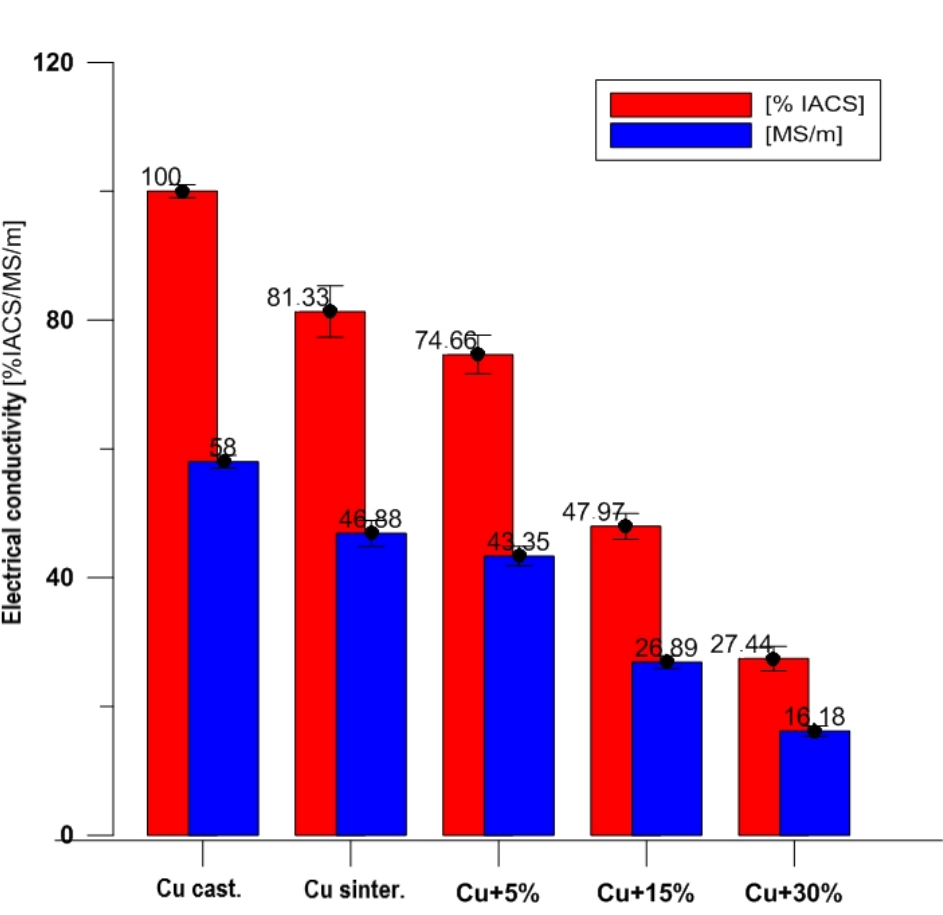
Figure 8. Electrical conductivity of compounds with Figure 8 . Electrical conductivity of compounds with tuff.